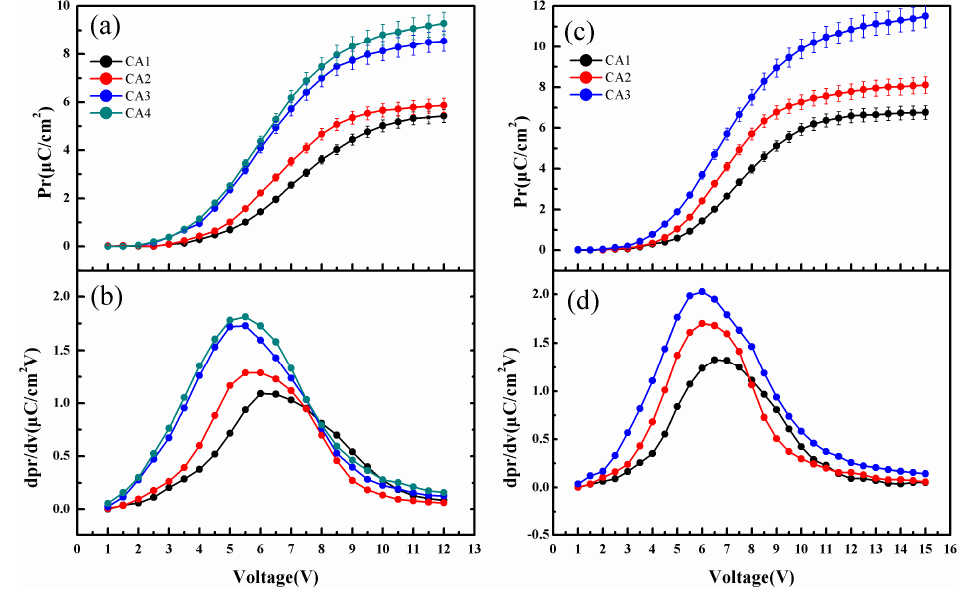
Figure 3. Pr and the first derivative value of P r . ( a ) P r as a function of the driver voltage from 1 V to 12 V; ( b ) The first derivative value of P r with the driver voltage from 1 V to 12 V; ( c ) P r as a function of the driver voltage from 1 V to 15 V; ( d ) The first derivative value of P r with the driver voltage from 1 V to 15 V.